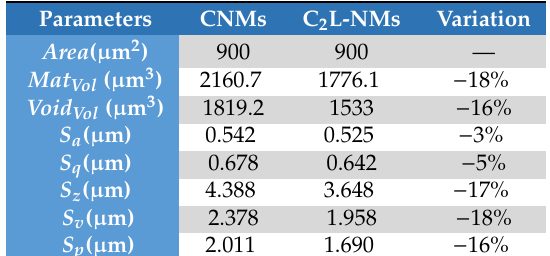
Table 1. Roughness parameters of the electrospun nanofabrics CNMs and C 2 L-NMs. Area = area scanned by AFM; Mat vol = volume of the material; Void vol = volume of the voids within the scanned area; S a = roughness average (i.e., the difference in height of each point compared to the arithmetical mean of the surface), S q = the root mean square value of ordinate values, S z = the sum of the largest peak height value and the largest pit depth value, S v = the absolute value of the height of the largest pit, and S p = the height of the highest peak.